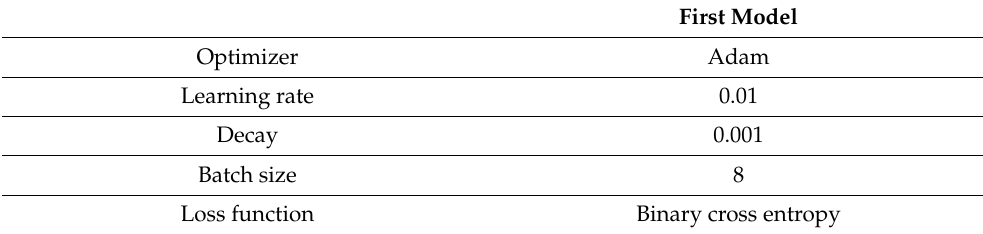
Figure A2. Limited-trained network architecture. Table A1. Limited-trained model’s characteristics.